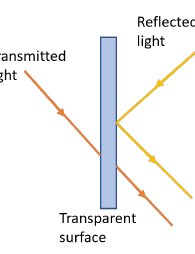
Figure 6. Light emission from a transparent surface is in general a combination of reflected and transmitted